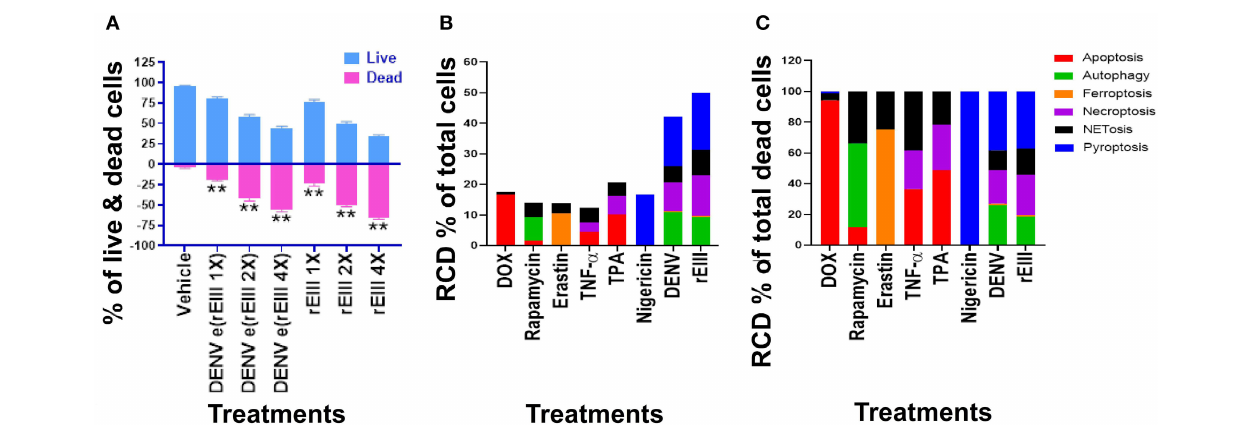
FIGURE 3 | DENV- and rEIII-induced regulated cell death in neutrophils. (A) Wild type mouse neutrophils treated (1h) with vehicle and various doses of DENV and rEIII; the live and death cell populations were revealed by Zombie-NIR Kit labeling and flow cytometry analysis. [rEIII 1 × = 0.3 µ M, 2 × = 0.6 µ M, 4 × = 1.2 µ M,; DENV e(rEIII 1 × ) is a DENV level equivalent to 0.3 µ M rEIII, as indicted by the methods described elsewhere (33)]. (B) Treatments (1h) of regulated cell death (RCD) inducers, doxorubicin (DOX; apoptosis) (2.5 µ g/mL), rapamycin (autophagy) (0.5 µ M), erastin (ferroptosis) (10 µ M), TNF- α (necroptosis) (2.5ng/mL), TPA (NETosis) (2nM), and nigericin (pyroptosis) (3.5 µ M) induced relatively simple RCD patterns. By contrast, DENV and rEIII induced multiple RCD pathways, in which pyroptosis is the major RCD response, counts ∼ 40% of total RCD and the NETosis response displays only ∼ 20% total RCD. (C) If the respective RCDs are normalized by the population of death cells (dead cell population normalized to 100%), we can obtain a more similar RCD pattern in DENV and rEIII groups (flow cytometry gating and calculation methods described in Supplementary Figure 2 ). DENV 1 × = 4.2 × 10 4 PFU/mL, 2 × = 8.4 × 10 4 PFU/mL, 4 × = 1.7 × 10 5 PFU/mL; ** P < 0.01 vs. vehicle